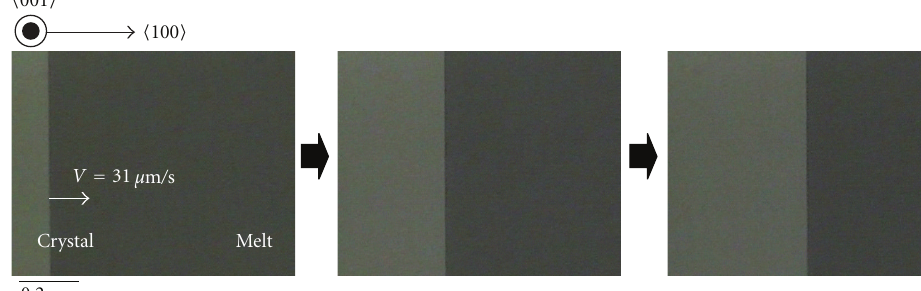
0.2 Figure 3: Morphology of Si (100) crystal-melt interface at low growth velocity